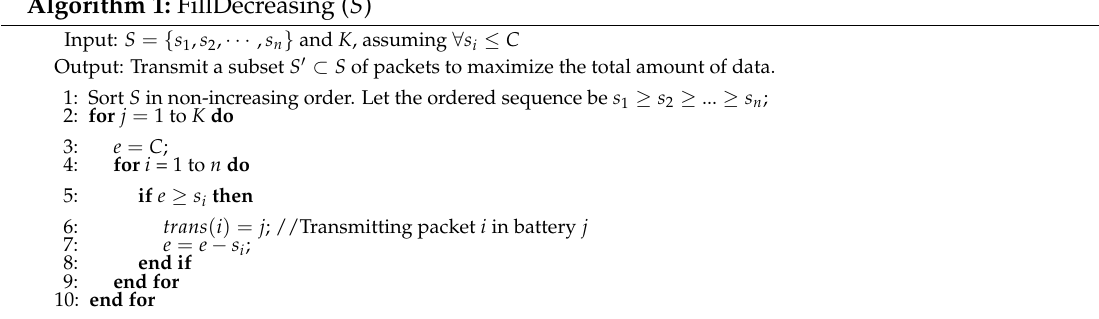
Algorithm 1: FillDecreasing ( S